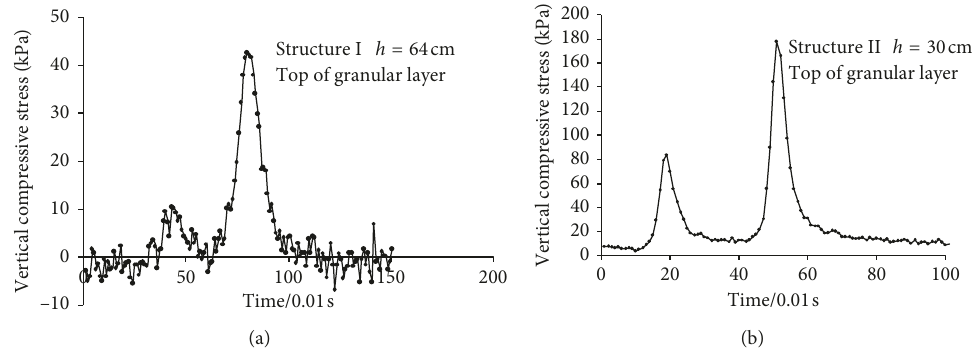
Figure 7: Vertical compressive stress at the top of the granular layer. (a) Structure I. (b) Structure